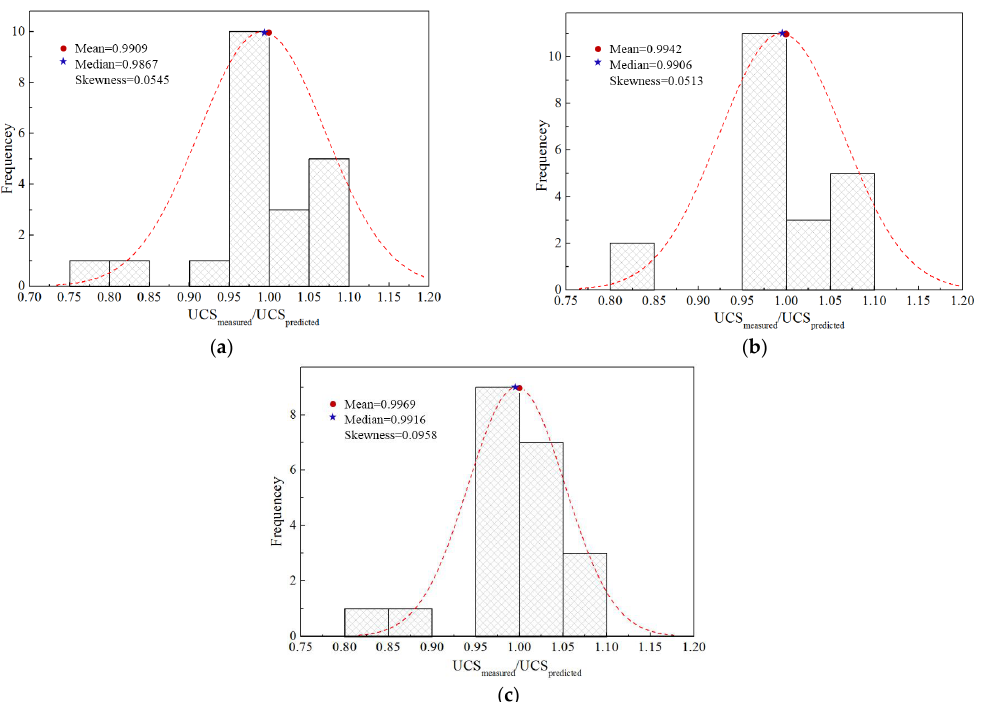
Figure 8. Histogram of UCS measured /UCS predicted based on the mathematical strength model at: ( a ) 7 d; ( b ) 14 d; ( c ) 28 d.